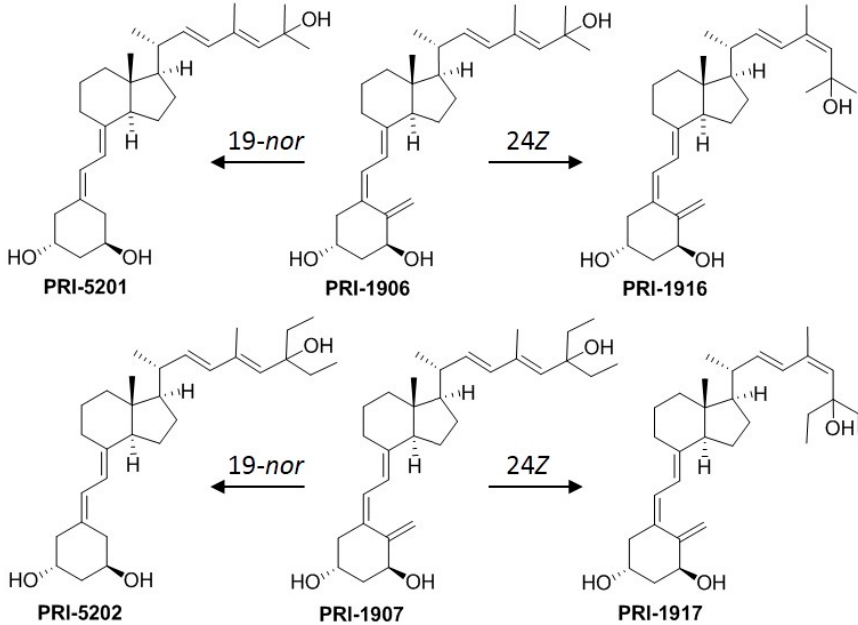
Figure 2. Structural 19- nor and 24 Z modifications of PRI-1906 and PRI-1907, the side-chain homologated and conjugated analogs of 1 α ,25-dihydroxyvitamin D 2 .